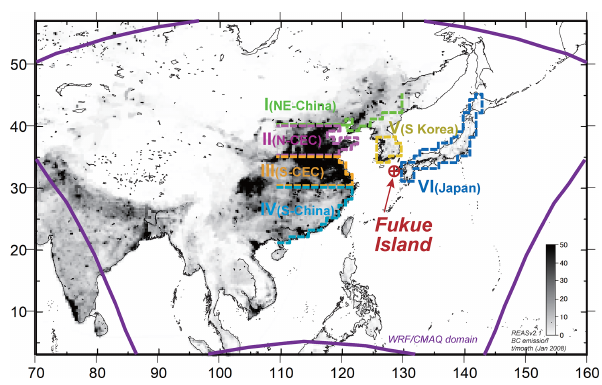
Figure 1. Location of Fukue Island (red), model domain (purple), and regional classification of air mass origin areas (regions I–VI). The background scale is the black carbon (BC) emissions. NE China – northeastern China; N-CEC – north-central East China; S-CEC – south-central East China; and S China – southern